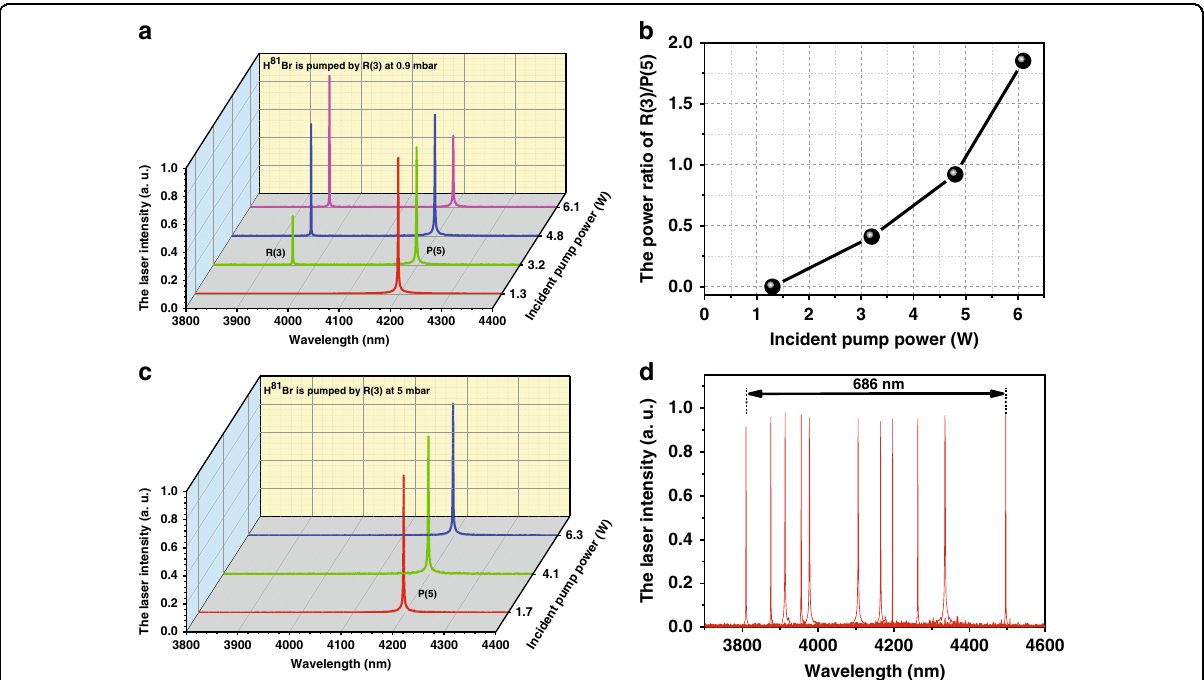
Fig. 4 Measured widely step-tunable mid-IR emission spectra. a Measured output spectra changing with incident pump power at 0.9 mbar when pumped at the R(3) absorption line. b Intensity ratio of the R(3) to P(5) lines changing with incident pump power. The P-branch laser line can be observed fi rst at a lower incident pump power owing to the larger cross-section than the R-branch laser line. c Measured output spectra changing with incident pump power at 5 mbar when pumped at the R(3) absorption line. d Measured output spectra of the HBr- fi lled HCF laser pumped at different absorption lines. From left to right are the R(11), R(7), R(5), R(3), R(2), P(2), P(4), P(5), P(7), P(9) and P(13) lasing transition